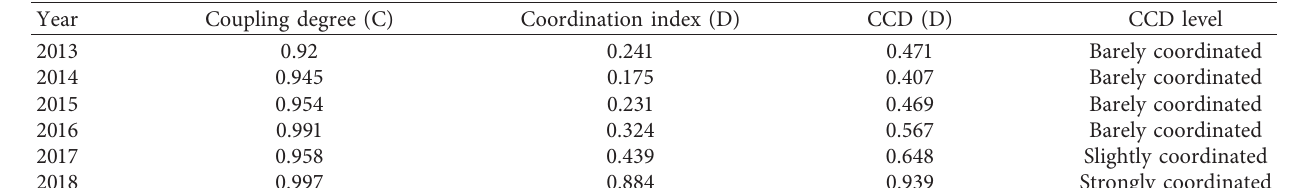
Table 3: CCD values.